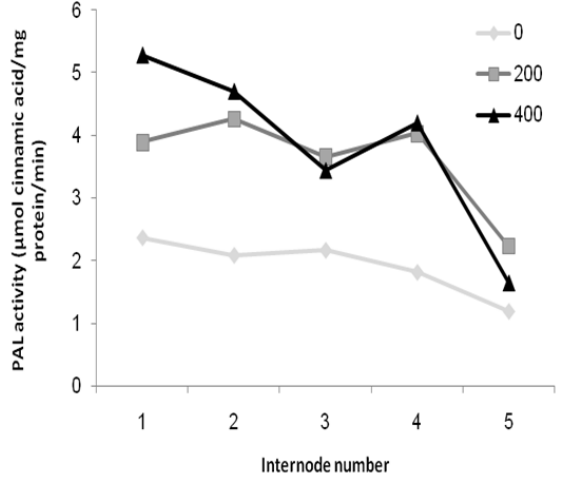
Fig. 1. Change in PAL activity under salt stress during internodal development. 1-5 Internode number from top; 1: upper and youngest internode and 5: lower internode. NaCl treatment: 0, 200 and 400 mM NaCl.